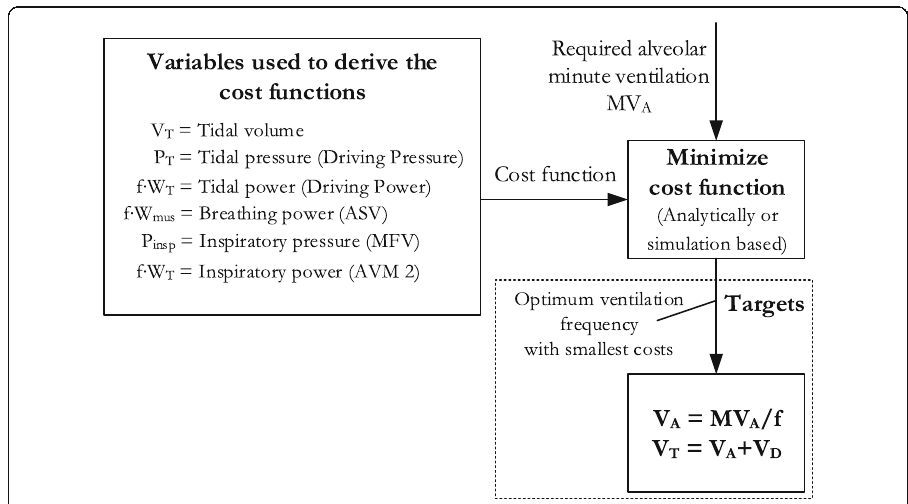
Fig. 1 Relation between cost functions and targets. Every cost function (tidal volume, tidal pressure, tidal power, breathing power, inspiratory power, and inspiratory pressure) was minimized analytically or using mathematical simulation. The result is the “ optimal ” ventilation frequency, which reaches the set alveolar minute ventilation and minimizes the cost function. After that, the frequency was used to calculate the target tidal